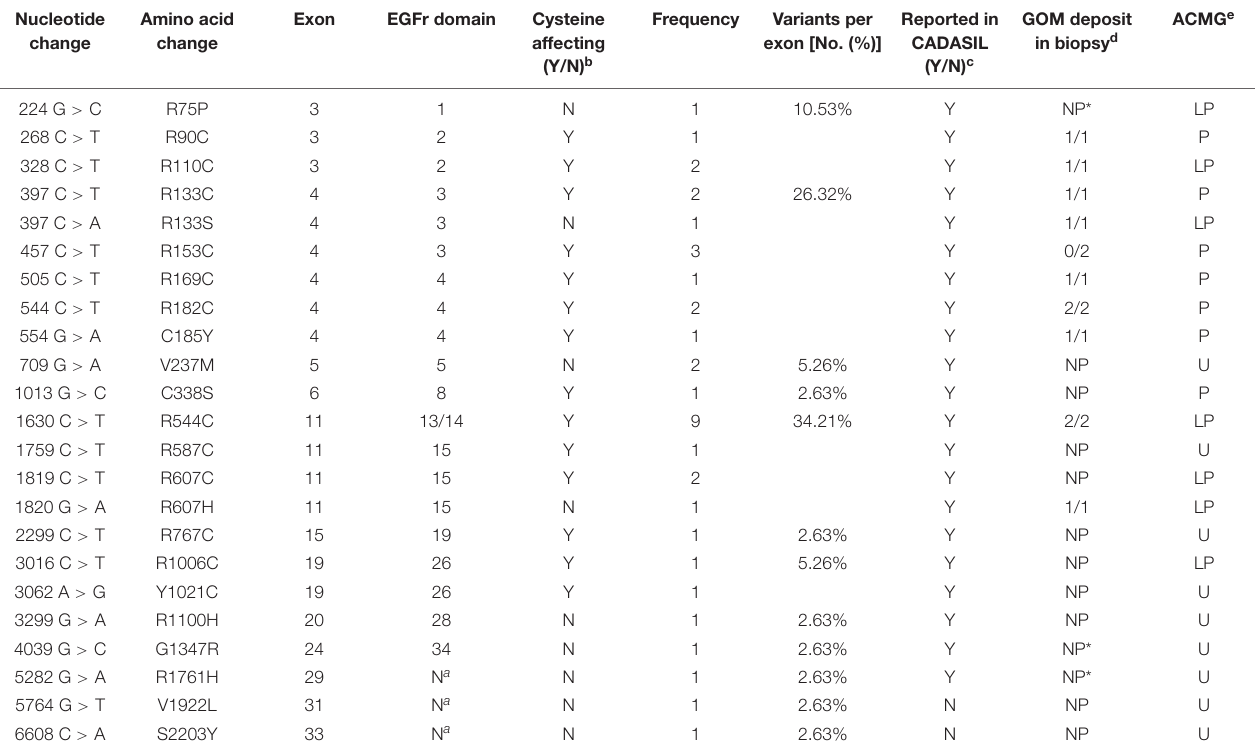
TABLE 2 | Spectrum of NOTCH3 variants found in 38 Chinese CADASIL patients. Nucleotide Amino acid change